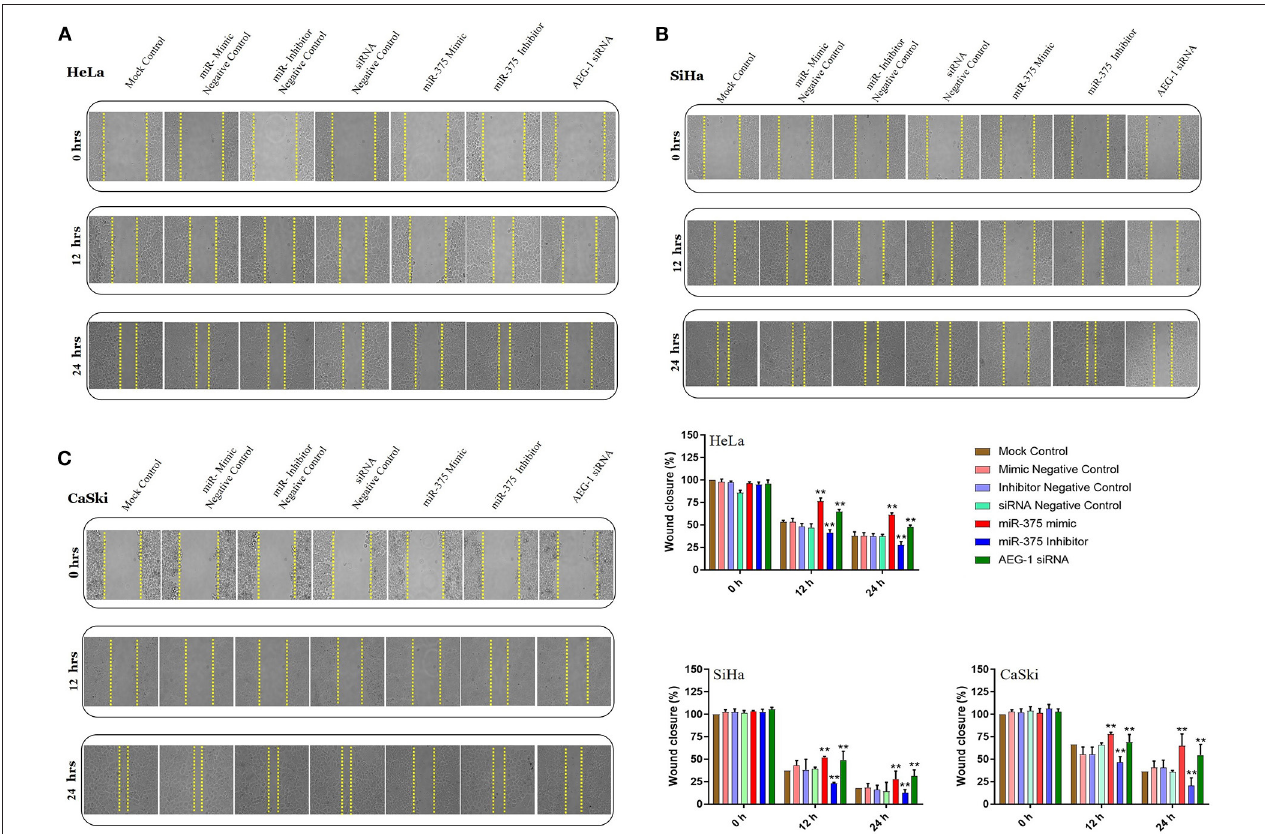
FIGURE 3 | Ectopic expression of miR-375 inhibits cervical cancer cell migration. in vitro scratch assay with HeLa (A) , SiHa (B) and CaSki (C) cell lines at 0, 12, and 24h post-transfection with miR-375 mimic, miR-375 Inhibitor, AEG-1 siRNA and their controls. Gap distance of cells was quantified by using Image J. The scale bars represent 100 µ m . Error bars represent mean ± s.d. and P- values are represented as ** P < 0.05 compared to the corresponding controls at a different time interval.